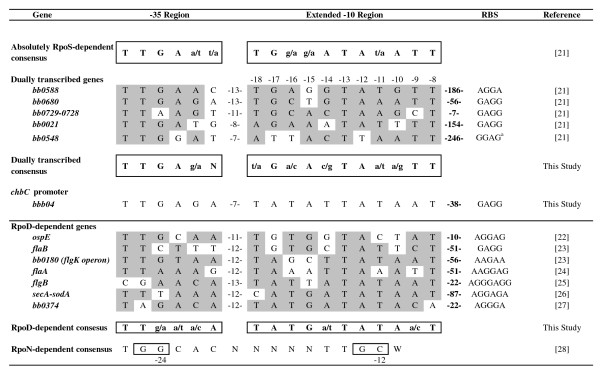
Identification of the chbC promoter. Comparison of the chbC promoter region with consensus promoter sequences for RpoS, dually transcribed, and RpoD-dependent genes. Nucleotide positions of promoters from dually transcribed and RpoD-dependent genes that match their respective consensus sequence are highlighted, and consensus sequences are boxed. The RpoN consensus sequence is also included for comparison, and the highly conserved GG and GC doublets at the -24 and -12 regions are boxed.